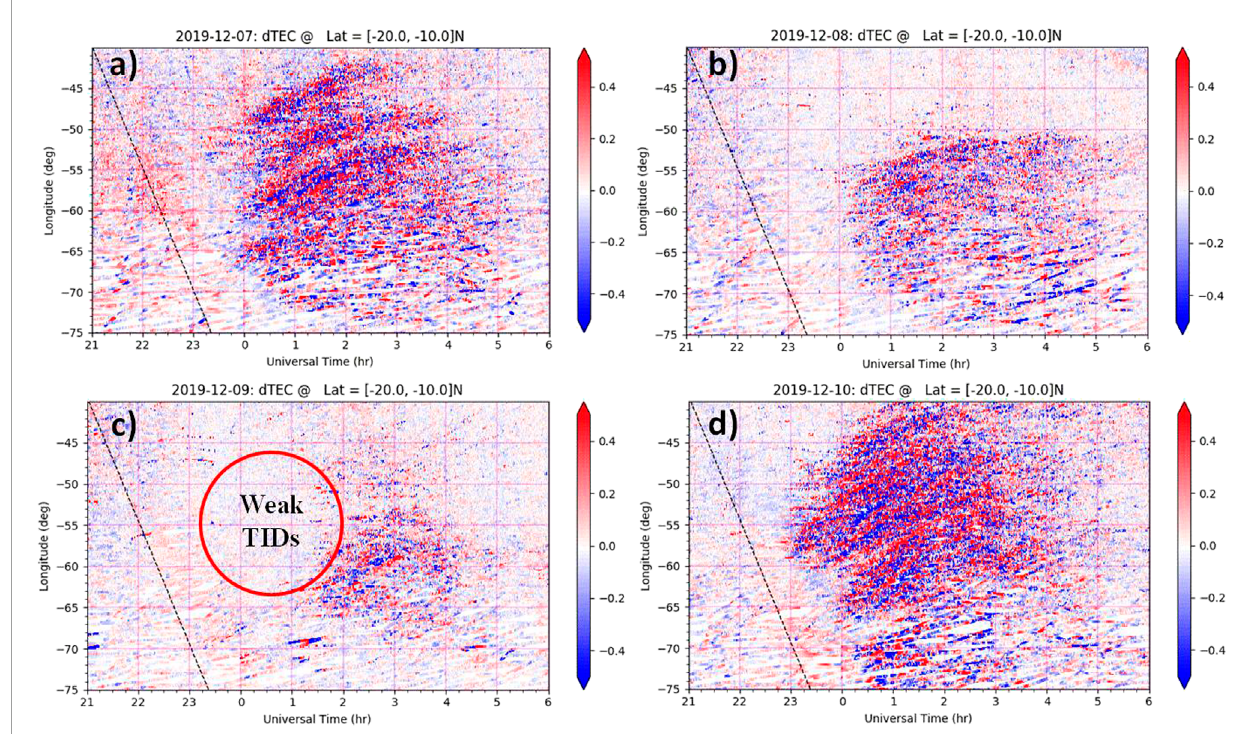
FIGURE 5 (A–D) Detrended TEC keogram as a function of time and longitude along −10 ∼ -20 ° latitude during 07–10 December 2019, respectively. The sunset terminator is marked with a dashed line. The red oval marks relatively weak TID intensity in panel c.